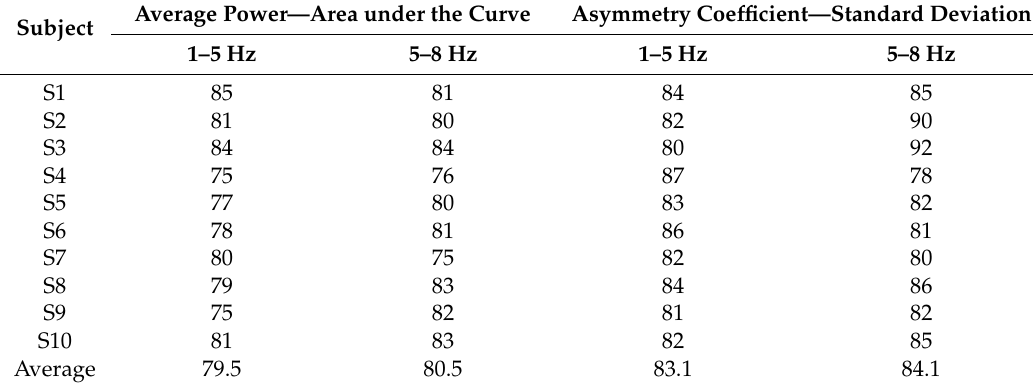
Table 2. Performance obtained in the classification process with the SVM algorithm